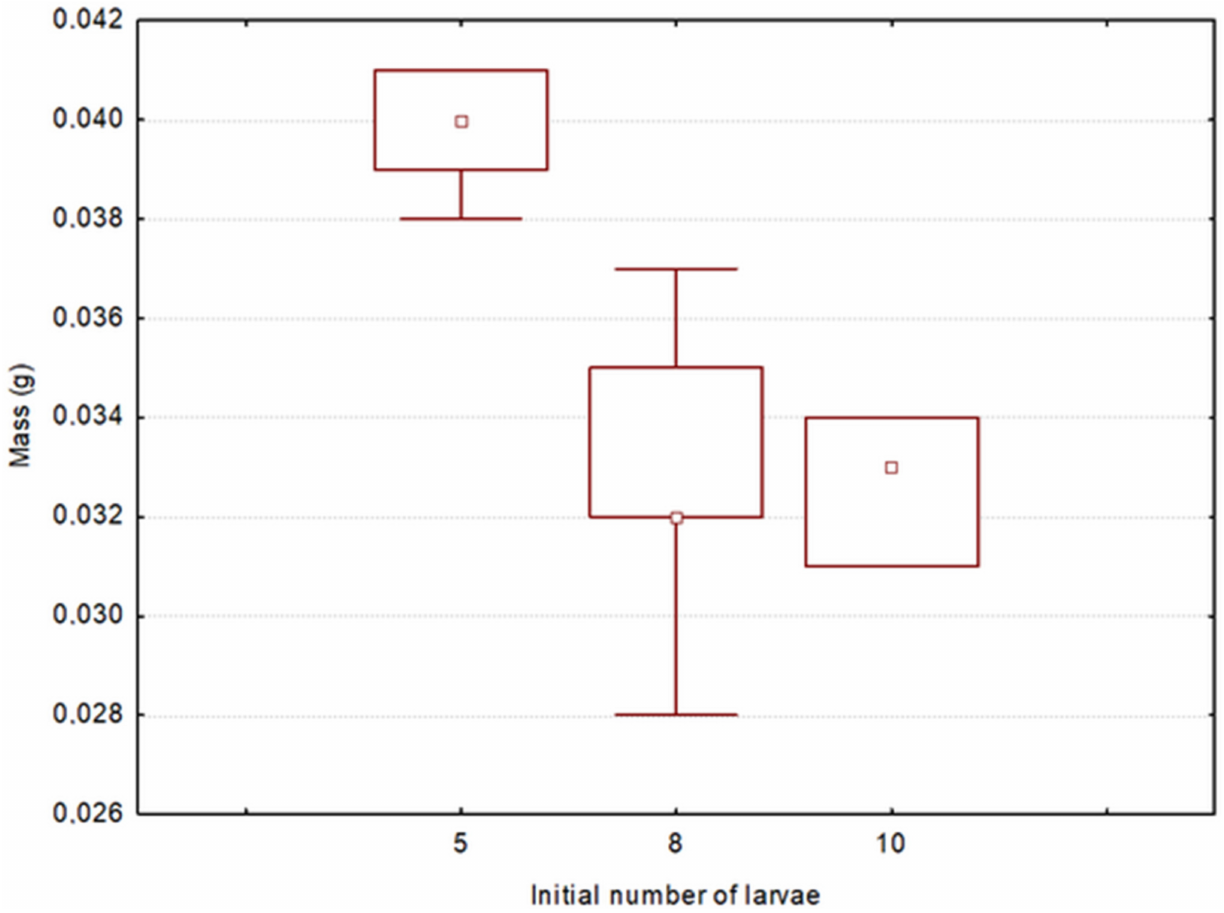
Figure 6. Distribution of larval masses in acorns with a final number of five larvae per acorn and an initial one of five, eight and ten larvae. Markings: squares—medians, box—quartile range (25–75%), whiskers—min/max